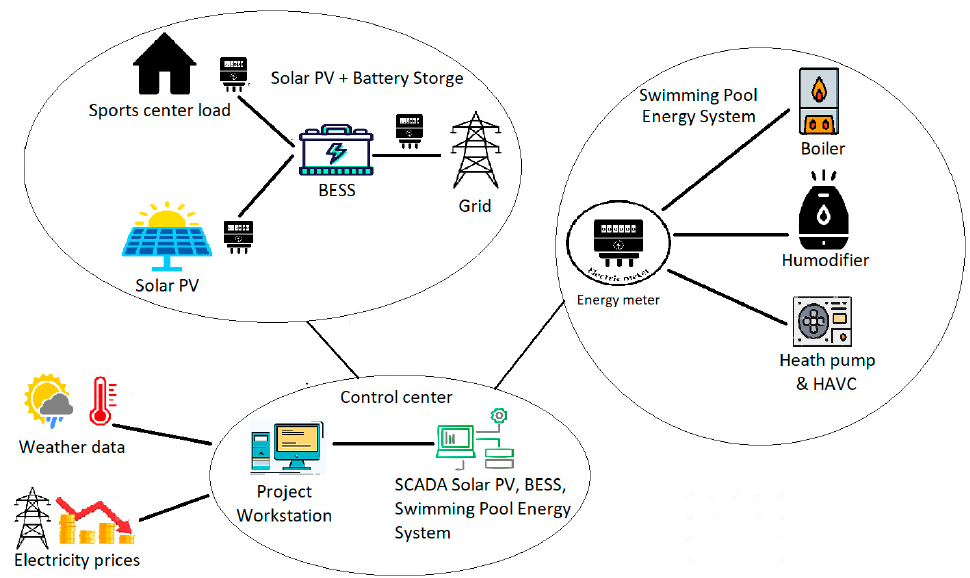
Figure 3. Physical view of the sports center premises. The figure presents a rough sketch to illustrate the main components of the case study.